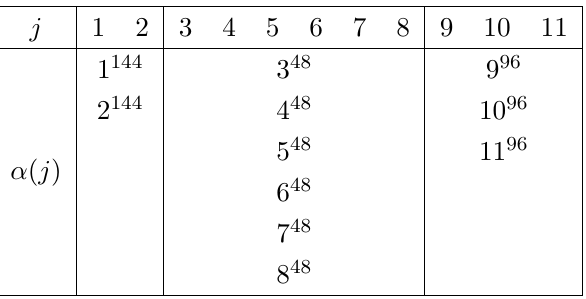
Table 1 . Table of (cid:11) ( j ) for 1 (cid:20) j (cid:20) 11 and (cid:11) 2 S 2 [ Z 1 ] (cid:1) S 3 [ Z 2 ] (cid:1) S 1 [ Z 3 ]. The symbol a b means that the number a appears b